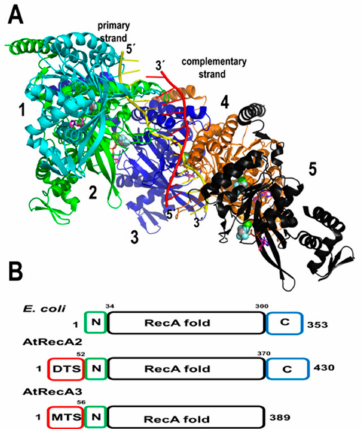
Figure 4. Structural conservation of plant and bacterial RecAs. ( A ) Crystal structure of the bacterial RecA postsynaptic nucleoprotein filament determined by Chen, Yang, and Pavletich [83]. Each of the five RecA monomers is individually colored and labeled with numbers. The search strand is colored in yellow and the complementary strand in red. The crystal structure comprises solely the RecA fold and the C-terminal domain is not present in the initial construct. ( B ) Domain organization of AtRecA2 and AtRecA3 in comparison to bacterial RecA. AtRecA3 lacks the C-terminal regulatory